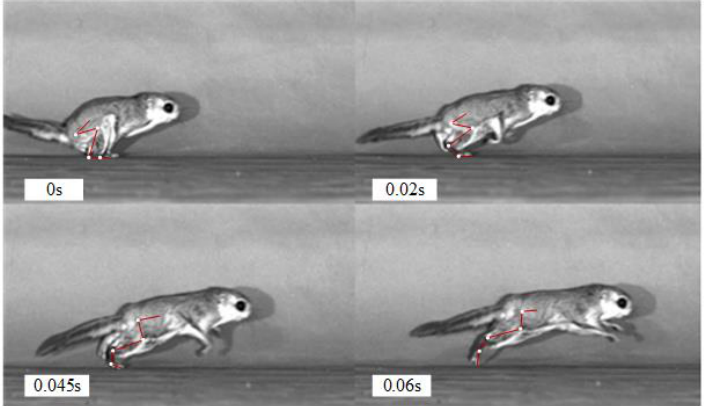
Figure 4. Motional sequence of jumping for progress of the flying squirrel. The white dots are the markers on the joints of the hind limb, and the red lines denote the linkages between the joints.